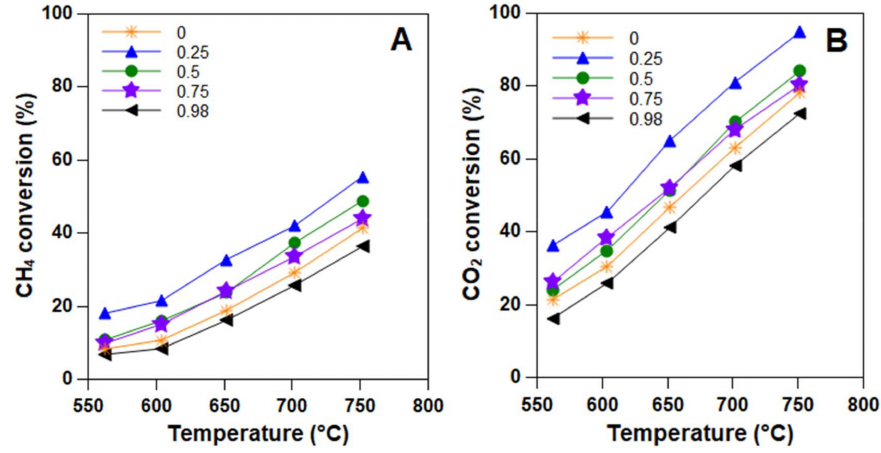
Figure 1. Impact of surfactant/cation (S/C) molar ratio on CH 4 ( A ) and CO 2 ( B )